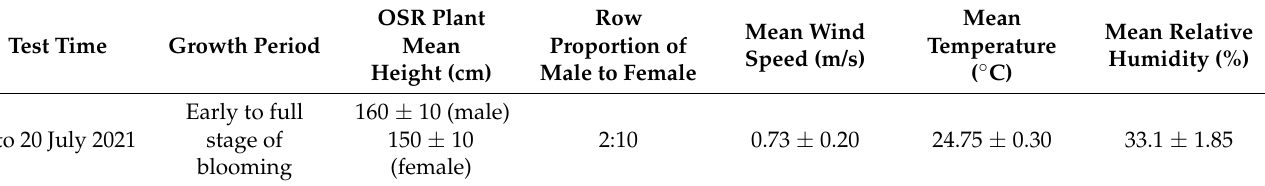
Table 1. OSR plant characteristics and weather conditions.